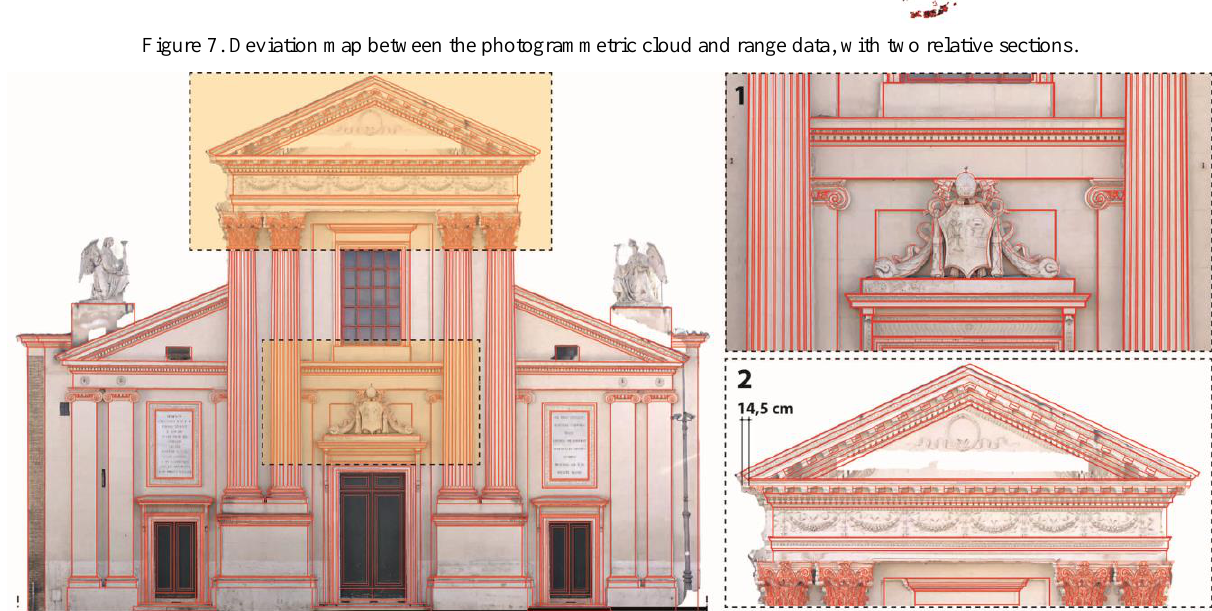
Figure 7. Deviation map between the photogrammetric cloud and range data, with two relative sections.